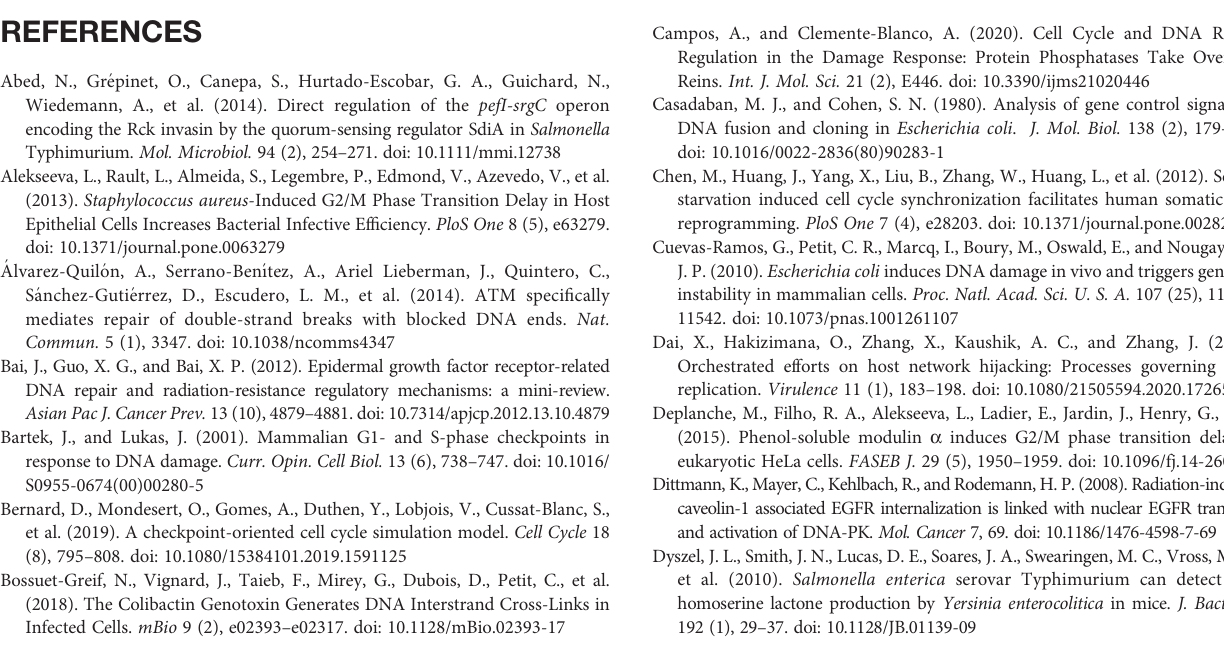
SUPPLEMENTARY FIGURE 1 | Percentage of infected cells based on GFP fl uorescence. HCT116 cells were infected with either MC-Rck, MC-GFP, or MC- RckGFP strain for 1 h at 37°C (MOI of 100). (A) The percentage of infected cells was determined using fl ow cytometry based on bacterial GFP expression. Cells